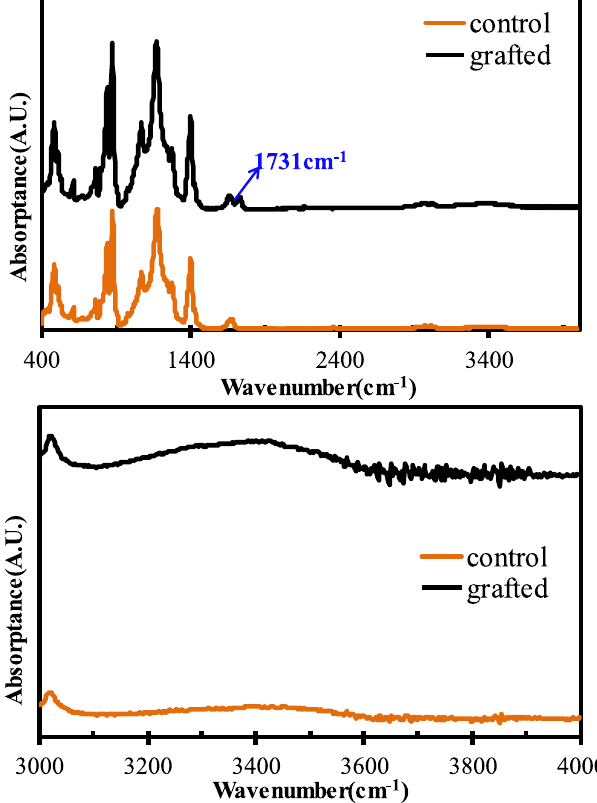
Figure 3. FTIR spectra profiles of the control and grafted membranes: ( a ) scan scope of 400 cm − 1 − 4000 cm − 1 ; ( b ) the scan scope of 3000 cm − 1 − 4000 cm − 1